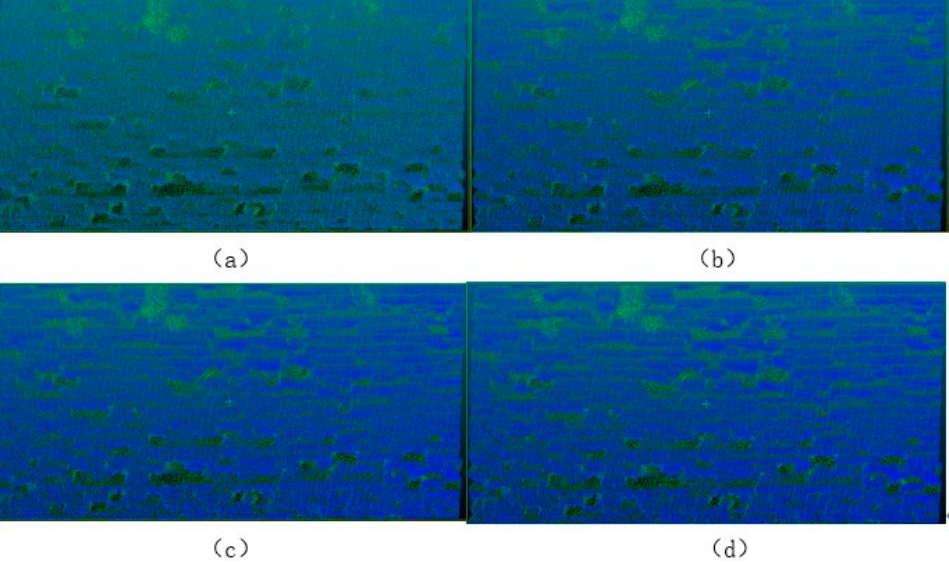
Figure 22. Point cloud marked by Structure Tensor Omnivariance. ( a ) K = 4. ( b ) K = 6. ( c ) K = 8. ( d ) K = 10.